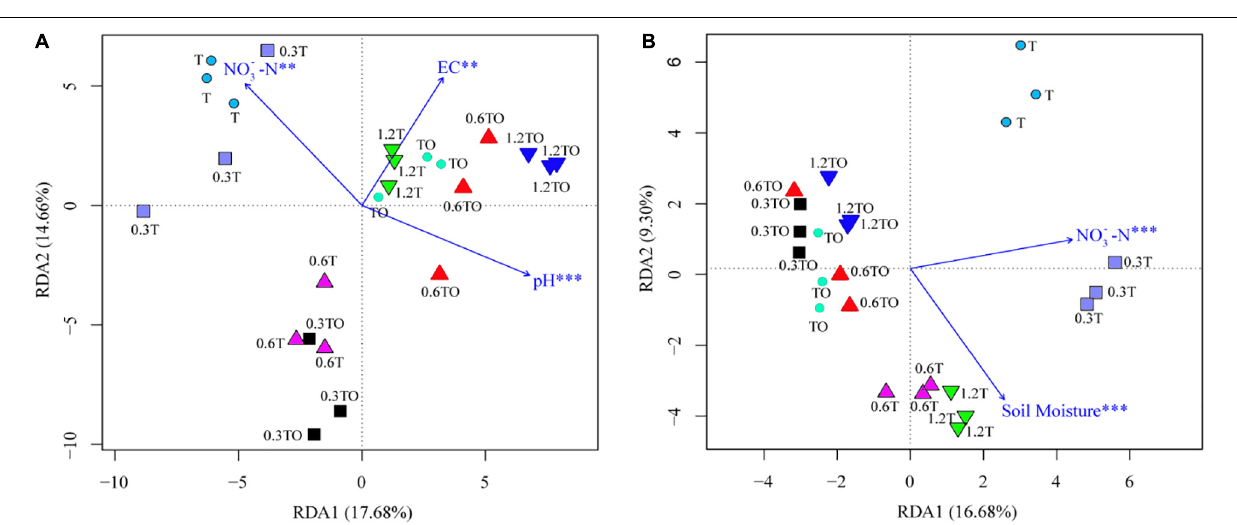
FIGURE 7 | Redundancy analysis (RDA) of tomato rhizosphere total bacterial (A) and fungal (B) community structures at 30 days in 2019. The environment variables with statistical significance are presented by arrows. T and TO indicate tomato monoculture and intercropped with potato–onion, respectively. 0, 0.3, 0.6, and 1.2% indicate the biochar rates. ** P < 0.01; *** P <